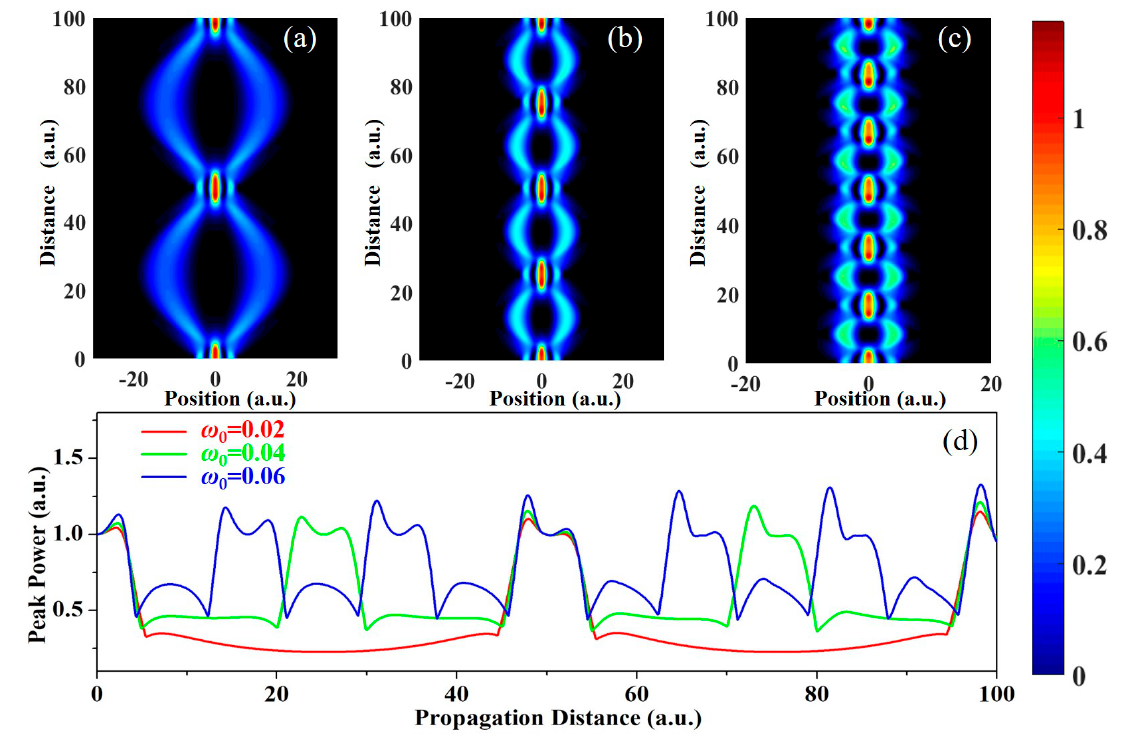
Figure 6. When x 0 = 1, ϕ 0 = 2 π /3, P 0 = 10, the spatial evolution of Cos − Gaussian pulses with three different modulation frequencies: ( a ) ω 0 = 0.02, ( b ) ω 0 = 0.04, and ( c ) ω 0 = 0.06; ( d ) the peak power evolution of the breathing solitons: ω 0 = 0.02 (red line), ω 0 = 0.04 (green line), and ω 0 = 0.06 (blue line).